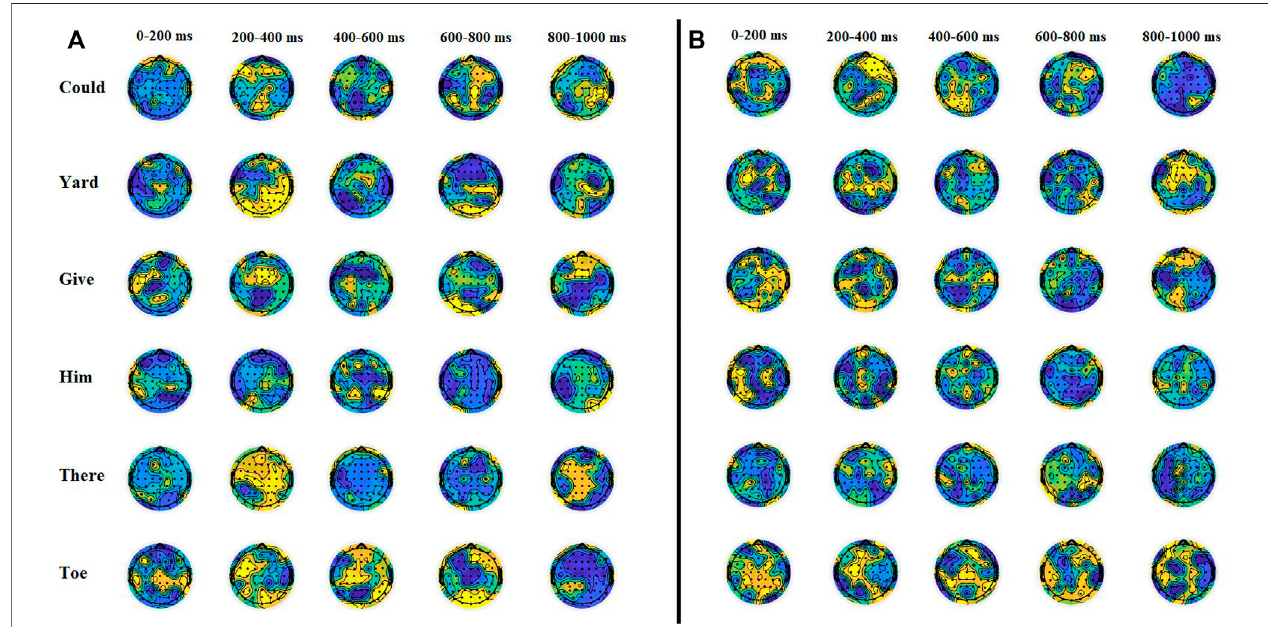
FIGURE 5 | Topographical distribution of (A) beta and (B) gamma band activities for different imagined words. The pattern of beta wave ’ s amplitude in the left temporal region was signi fi cantly different during 0 – 200 m ( p < 0.03 at T7) of onset. There were maximum beta and gamma activities observed for the word "toe," while activities were minimum in amplitude for the word "him." There is a high amplitude observed in both beta and gamma waves at both temporal regions for all words from 200 to 400 m of onset.